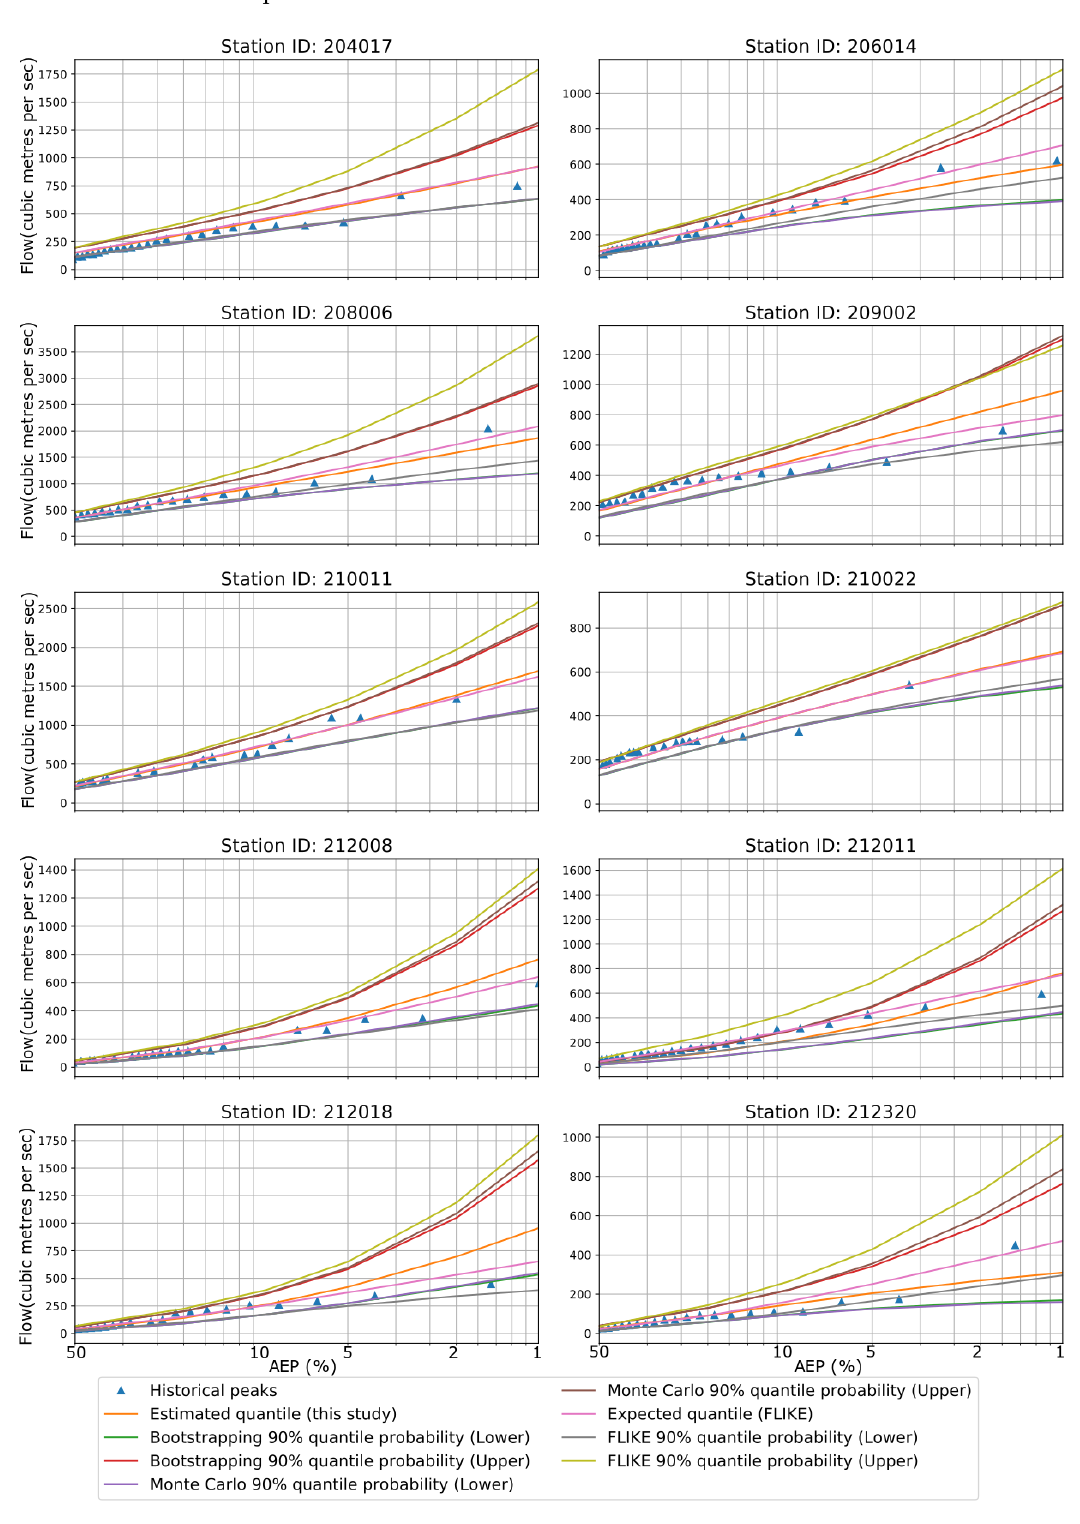
Figure 3. Flood quantiles from FLIKE and LP3 distribution are presented over various AEPs for all 10 stations. Confidence intervals (CIs) are estimated by FLIKE, BS, and MCST methods. The blue triangle symbolizes historical peak. triangle symbolizes historical